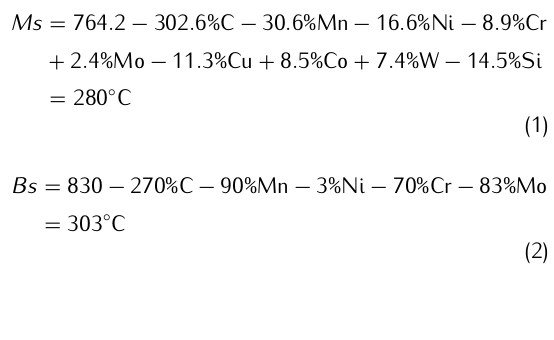
cooling after austenization before austempering of the 3Cr1.5Mo0.25VO.l steel with different velocity is the reason for the generation of structures different from the typical bainite structures. These structures